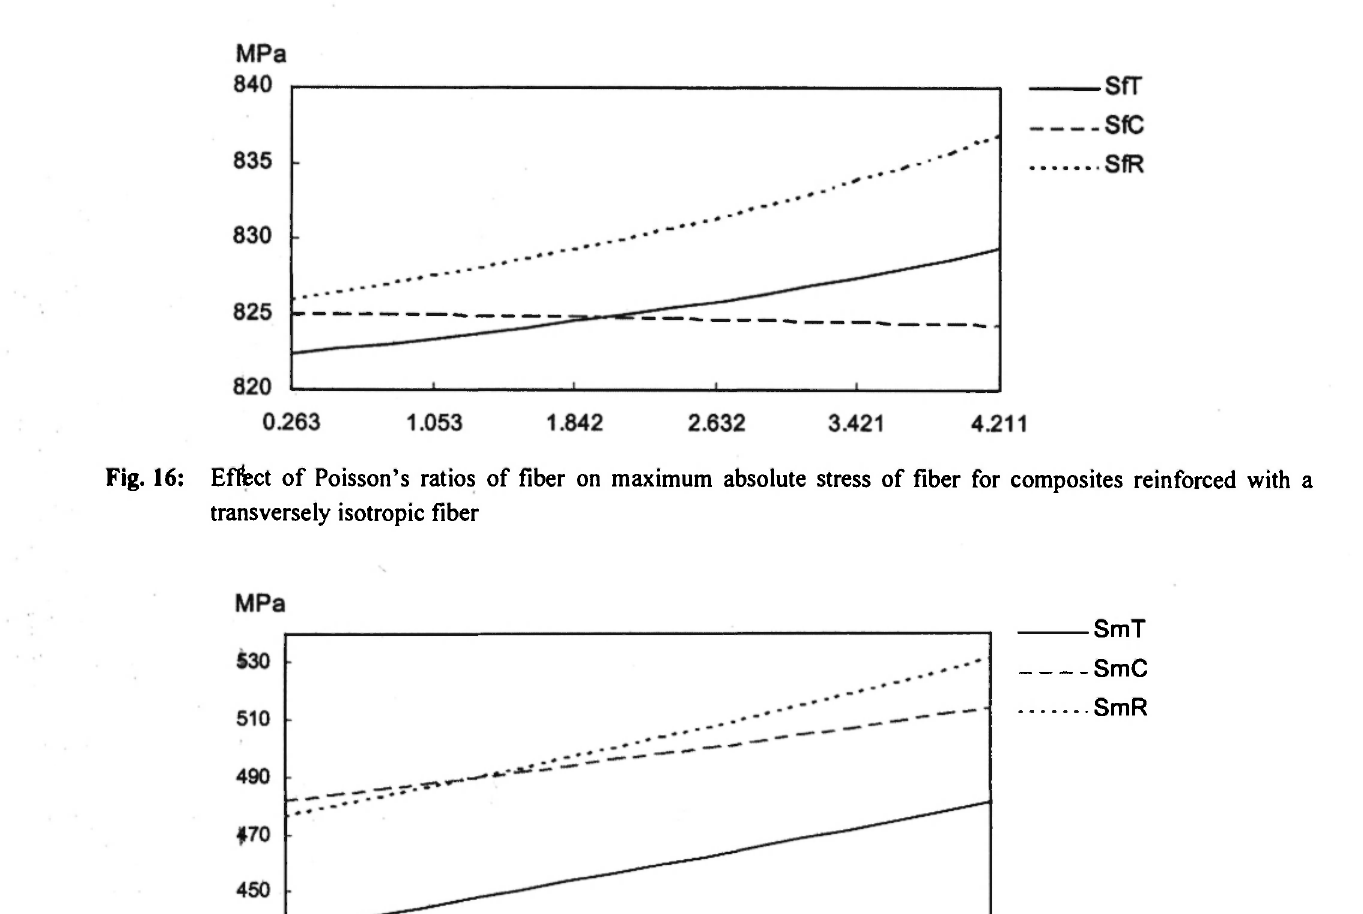
Fig. 17: Effect of Poisson's ratios of fiber on maximum absolute stress of matrix for composites reinforced with a